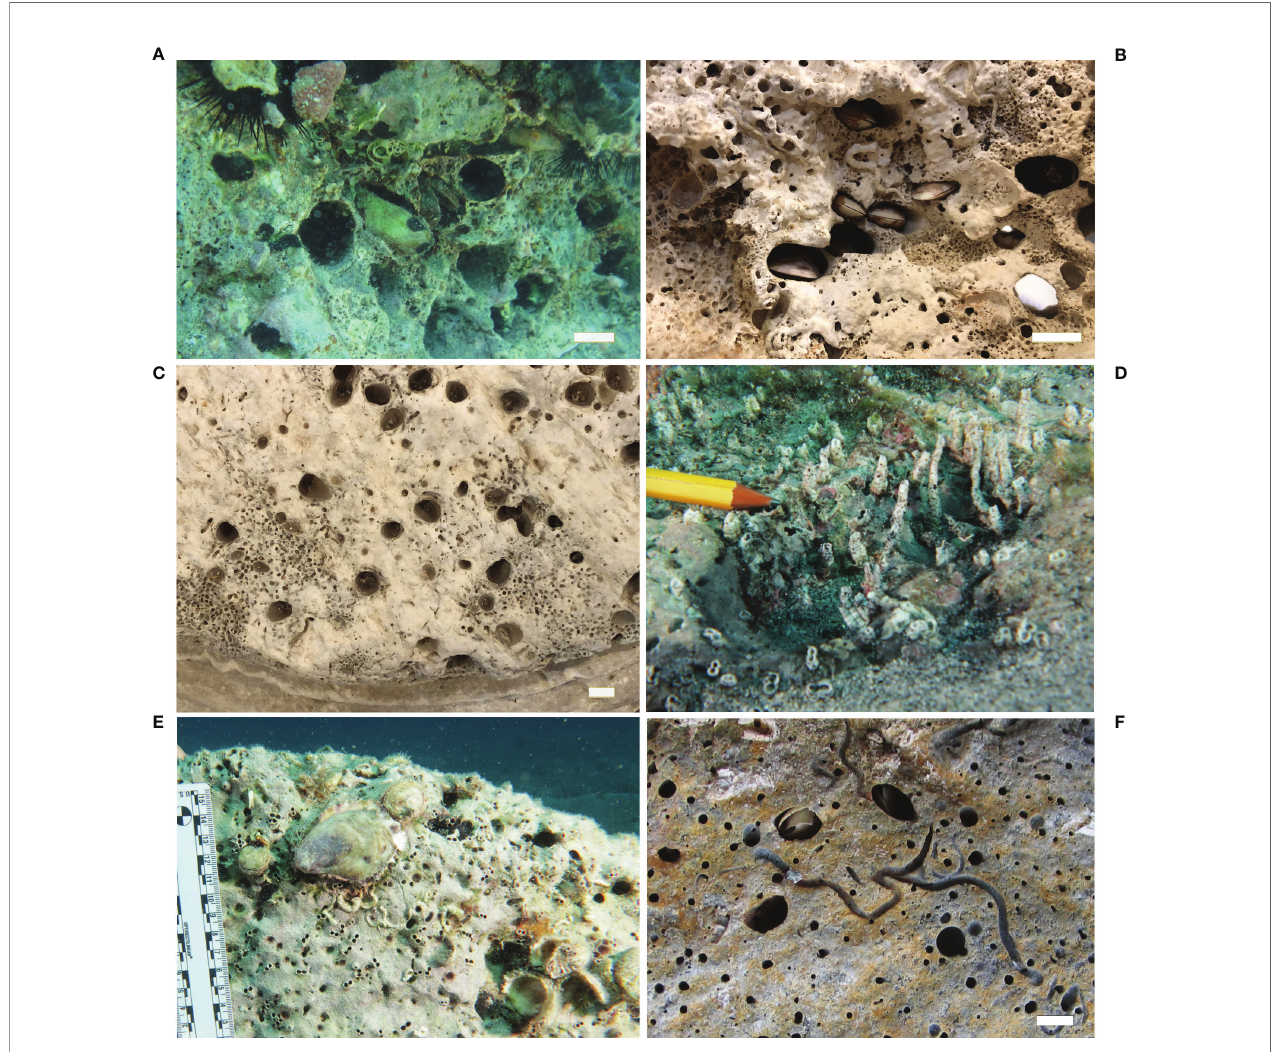
FIGURE 7 | Bivalves. (A) Specimen of Lithophaga lithophaga inside a calcarenite block in the underwater site of Epidaurus (underwater photo); (B) holes produced by L. lithophaga specimens in a marble sarcophagus in the National Archaeological Museum of Capo Colonna, Crotone*; (C) holes produced by L. lithophaga in a marble column base in the National Archaeological Museum of Capo Colonna, Crotone*; (D) aragonite tubes secrete by the bivalve Rocellaria dubia on a marble block in the ancient Kaulon submerged site, Monasterace (underwater photo)*; (E) 8-shape holes of R. dubia on a column drum in the ancient Kaulon submerged site, Monasterace, (underwater photo)*; (F) Petricola lithophaga : specimens and holes in a marble statue, Archaeological Museum of Campi Flegrei, Baiae. Scale bars: (A – C) = 2 cm; (F) = 1 cm. * = Photos produced in the frame of MUSAS Project - Museums of Underwater Archaeology - protection, enhancement and networking of the underwater archaeological heritage, Calabria-Campania-Puglia, of the Central Institute for Restoration, Italian Ministry of Culture (www.progettomusas.eu)